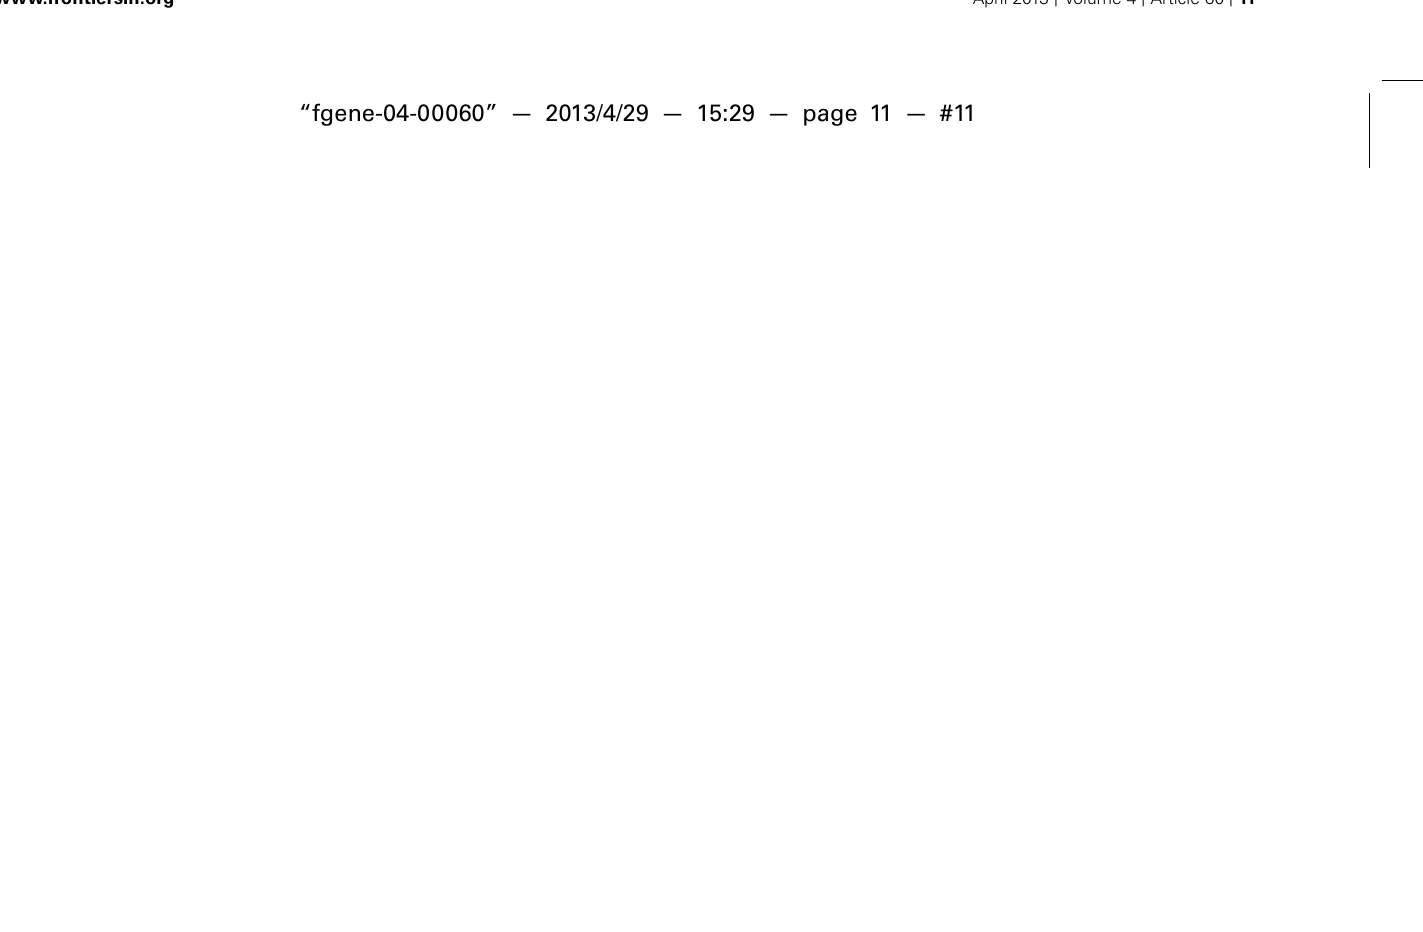
FIGURE 4 | Role of p97 in genome stability. The circle represents a summary of p97 functions in diverse cellular processes, from yeast to human, essential for maintenance of genome stability. Key players from different species are abbreviated with human homologous (e.g., yeast Cdc48 and Ubx5 is equivalent to human p97 and UBXD7).The p97 homohexamer is centrally located.The first ring (blue) represents two core adaptor complexes, Ufd1–Npl4 and p47.The second ring (orange) represents the next tier of p97 adaptors that direct the function of p97 core complexes. DVC1 directs p97 − Ufd1 − Npl4 function towardTLS, and UBXD7 and UBXD9 direct p97 − Ufd1 − Npl4 toward stalled transcription andTC-NER.The third ring (gray) represents E3 ubiquitin ligases that ubiquitinate p97-substrates.The